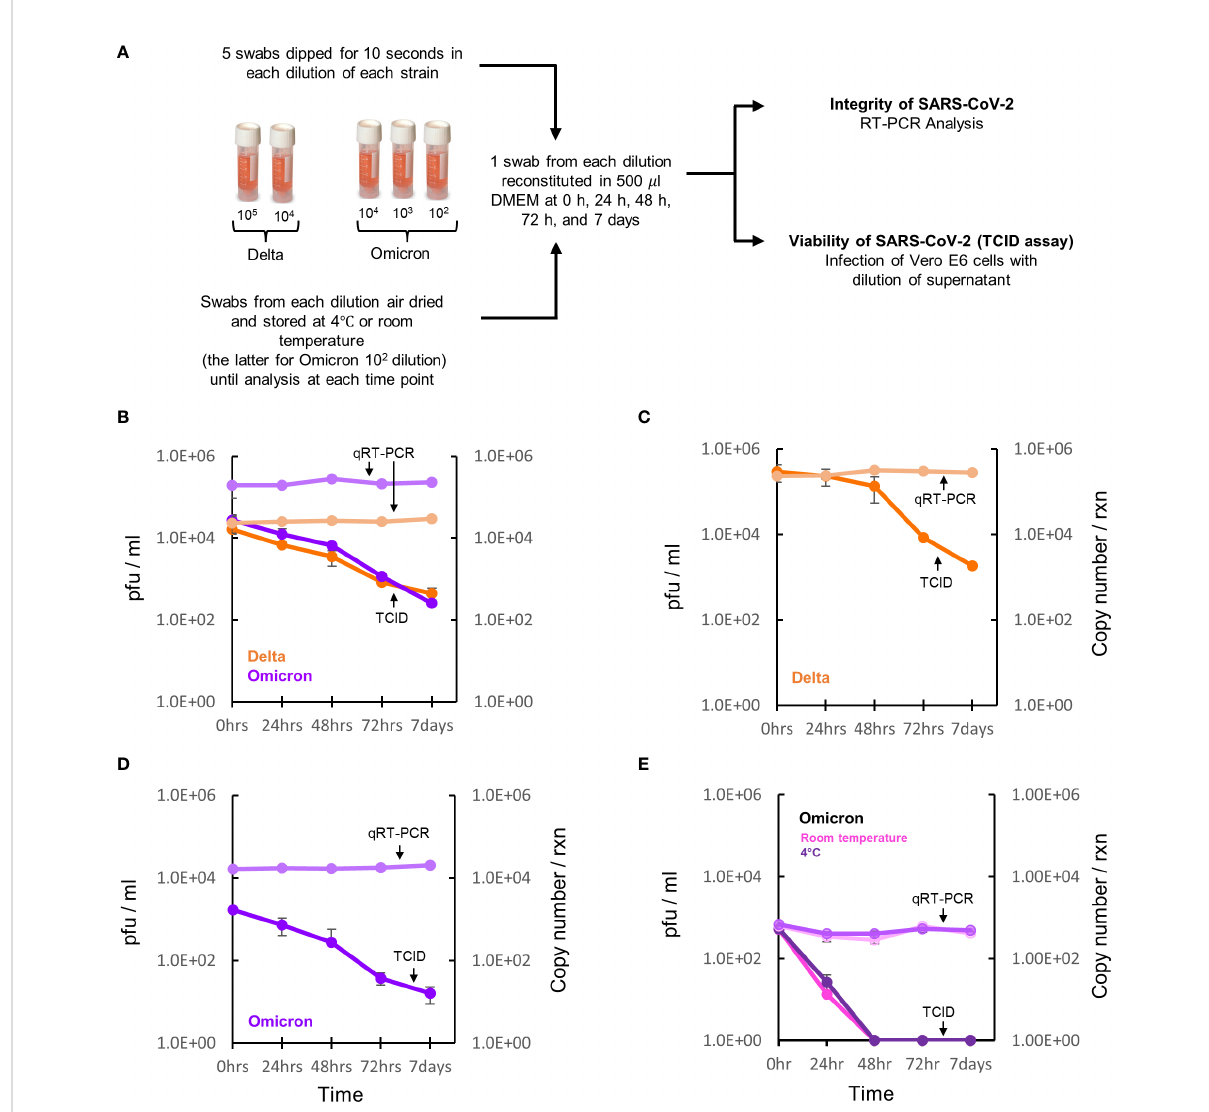
FIGURE 3 Survival of SARS-CoV-2 on dry swabs. (A) Five swabs were coated with either a high (10 5 ), medium (10 4 ), low (10 3 ) or very low (10 2 ) copy number/reaction as determined by qRT-PCR of the Delta or Omicron variant and stored at 4°C. The swabs coated with the very low concentration of Omicron was additionally tested at room temperature. At time 0 hrs, 24 hrs, 48 hrs, 72 hrs and 7 days, the stored dry swabs were reconstituted in media and then tested for viability and genome integrity using TCID assays and qRT-PCR, respectively. (B) Viral recovery of the Delta (orange line) and Omicron (purple line) variants from the medium concentration is comparable at all time points with both strains showing a 2 log decline in pfu/ml after 7 days of storage. In contrast, RNA recovery from both viral variants (light orange=Delta and light purple=Omicron) at all the time points remained constant. (C, D) Viral viability and genomic recovery from swabs coated with a high dose of the Delta and medium dose of the Omicron variant, respectively. (E) Viral viability and genomic recovery from swabs coated with a very low dose of the Omicron variant with swabs either stored at room temperature (shown in pink) or 4°C (shown in purple) prior to processing at the various timepoints. Data represent three biological repeats and error bars represent the standard error of the